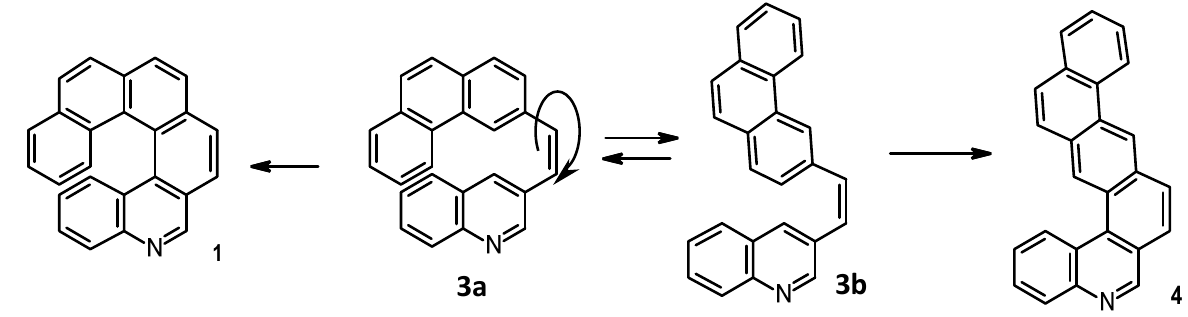
Scheme 2. Photochemical ring closure of the two conformers of precursor 3 .